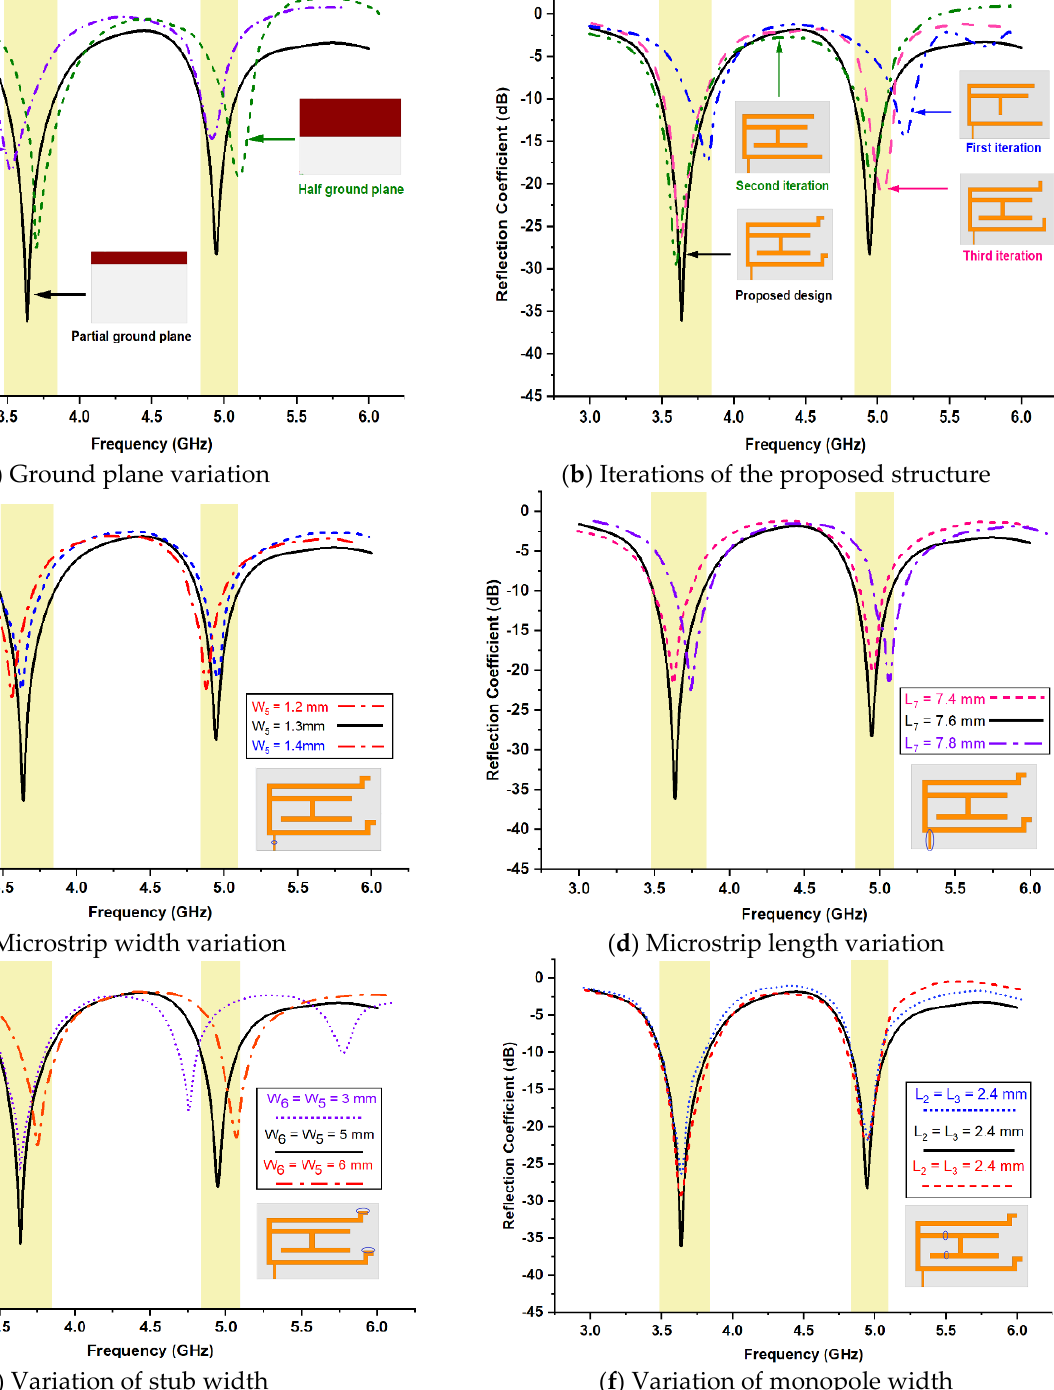
Figure 6. Parametric study of return loss from possible iteration. ( a ) Ground plane variation ( b ) Iterations of the proposed structure ( c ) Microstrip width variation ( d ) Microstrip length variation ( e ) Variation of stub width ( f ) Variation of monopole width